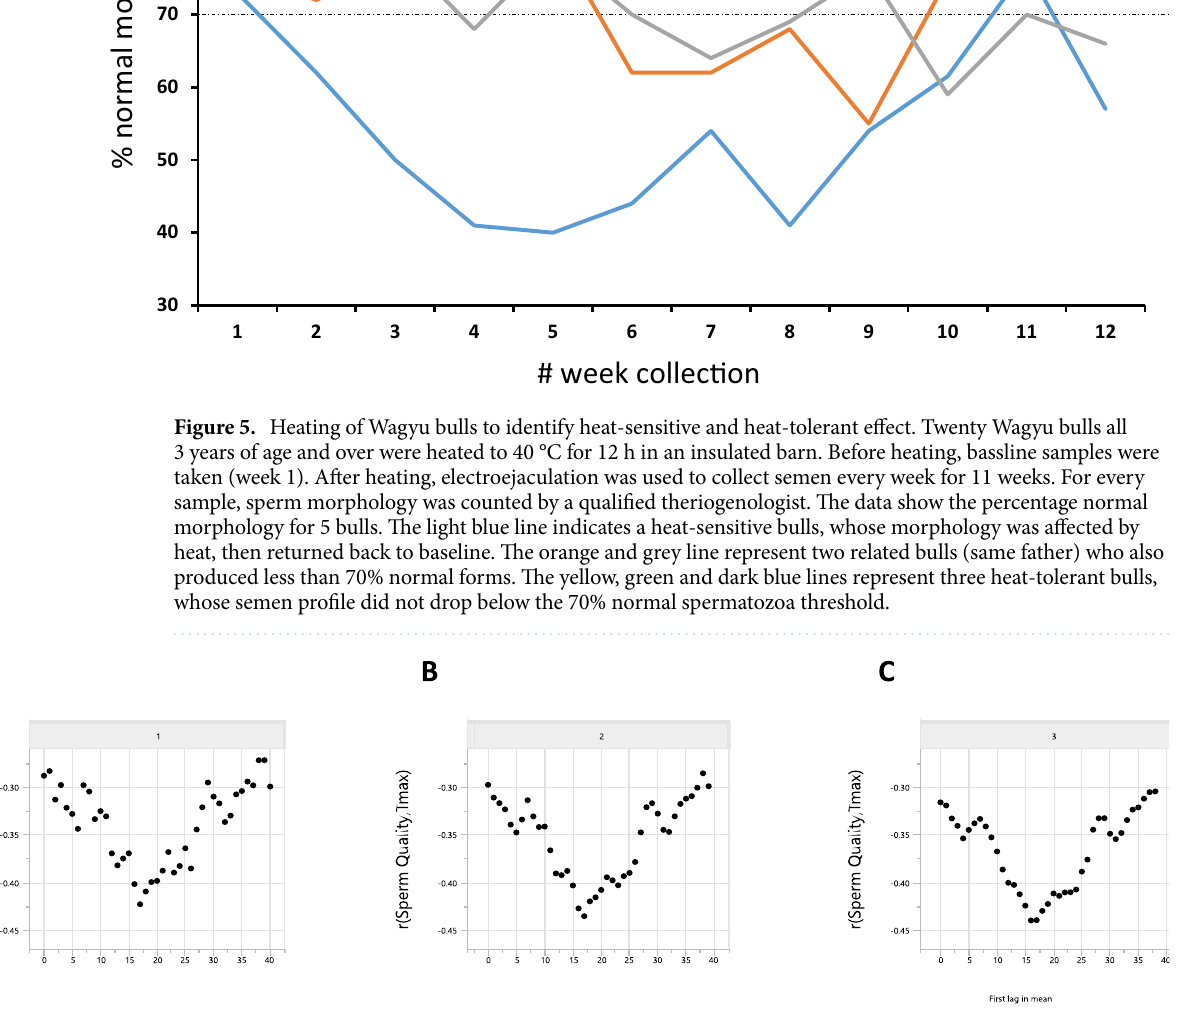
Figure 6. Bull semen quality (as percentage sperm normal forms) is related to the temperature that occurred 17–19 days ago. Correlation between sperm quality and maximum Temperature (Tmax). The Y axis is the Pearson correlation coefficient and X axis represents the number of days before the day the sperm sample was taken. ( a ) Uses one day of Tmax data whilst ( b ) averages two and ( c ) averages three consecutive days of Tmax data. The arrow shows the best correlation between Tmax and poor sperm quality, which occurs around 17–19 days before the semen sample is